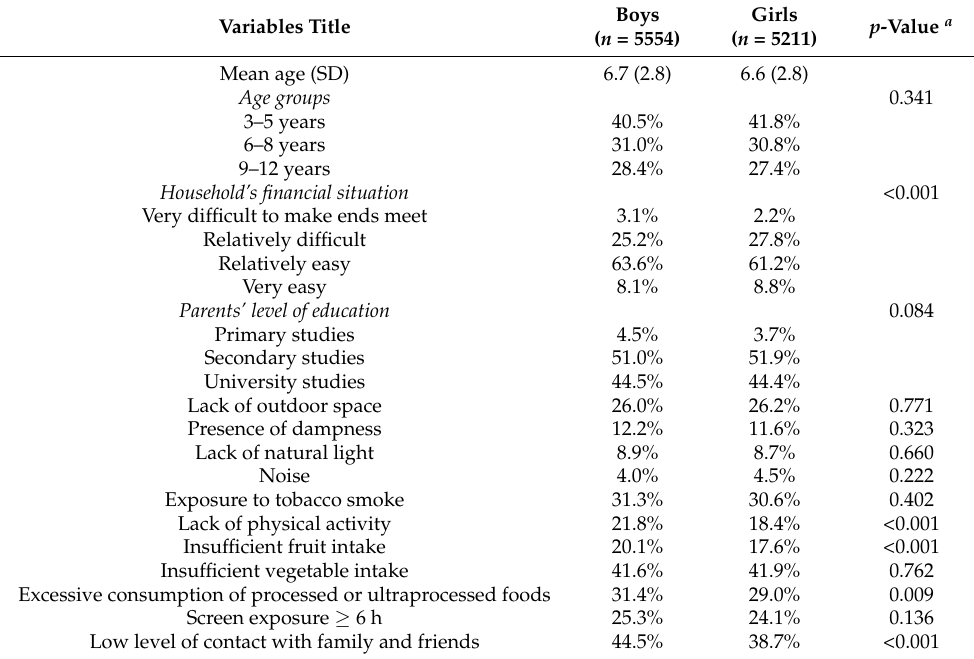
Table 1. Sociodemographic characteristics of the sample and prevalence of the health determinants analyzed according to